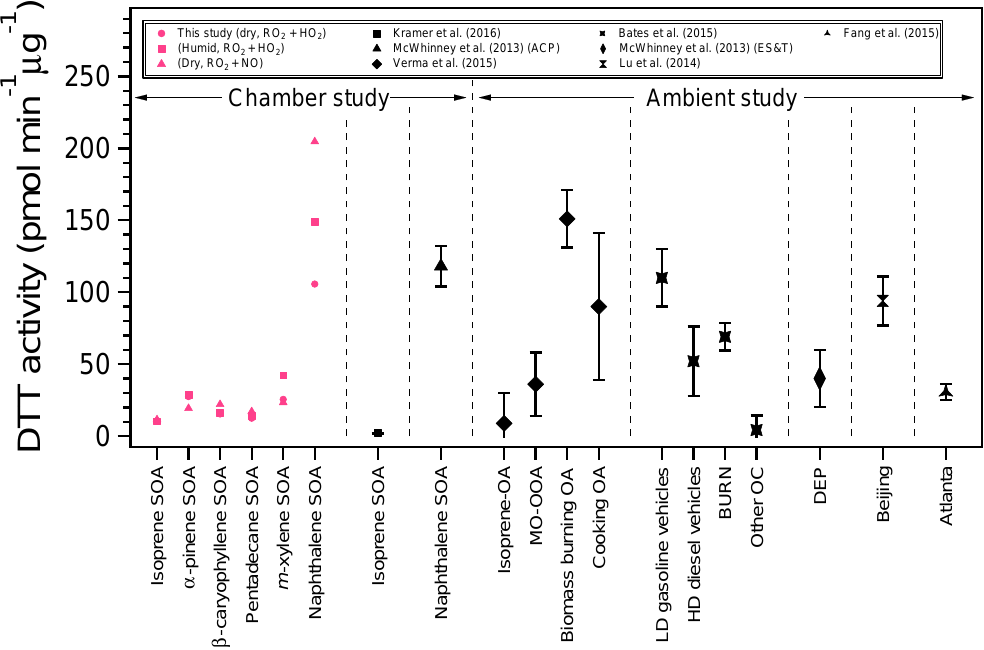
Figure 4. Intrinsic DTT activities for chamber SOA, various PM subtypes resolved from ambient data, and diesel exhaust particles. It should be noted that the DTT activity for isoprene SOA in Kramer et al. (2016) was determined using a different DTT method and may not be directly comparable. All other studies shown used the method outlined in Cho et al. (2005). DTT activities obtained in this study are shaped by reaction condition (circle: dry, RO 2 + HO 2 ; square: humid, RO 2 + HO 2 ; triangle: dry, RO 2 + NO). Specifics on site locations and factor resolution methods are described elsewhere. DTT activities for Beijing and Atlanta are averages obtained across multiple seasons. Isoprene-OA: isoprene-derived OA, MO-OOA: more-oxidized oxygenated OA, BBOA: biomass burning OA, COA: cooking OA, LDGV: light-duty gasoline vehicles, HDDV: heavy-duty diesel vehicles, BURN: biomass burning, DEP: diesel exhaust particles (Kramer et al., 2016; McWhinney et al., 2013b; Verma et al., 2015a; Bates et al., 2015; McWhinney et al., 2013a; Xu et al., 2015a, b; Lu et al., 2014; Fang et al.,